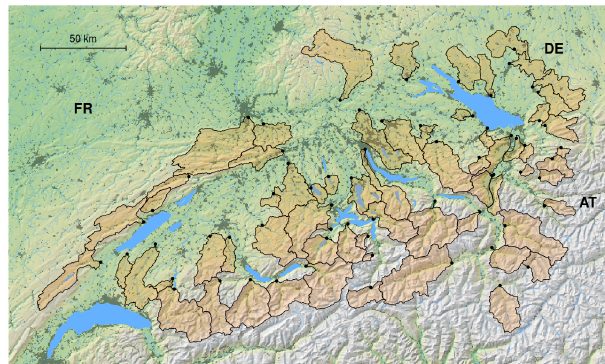
Figure 1. The study region comprises parts of Germany, Austria, and Switzerland. Grey shaded regions indicate urban areas, points mark gauging